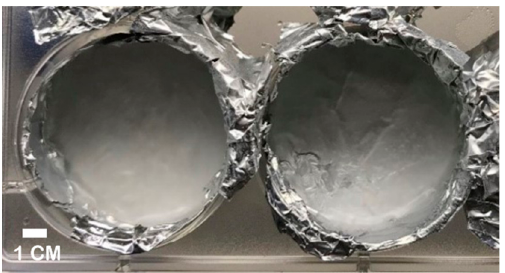
Figure 3. Frozen CaCl 2 on aluminum foil pressed against the interior of the wells of a 6-well plate. Disks were pulled out vertically, ensuring the integrity of frozen CaCl 2 .